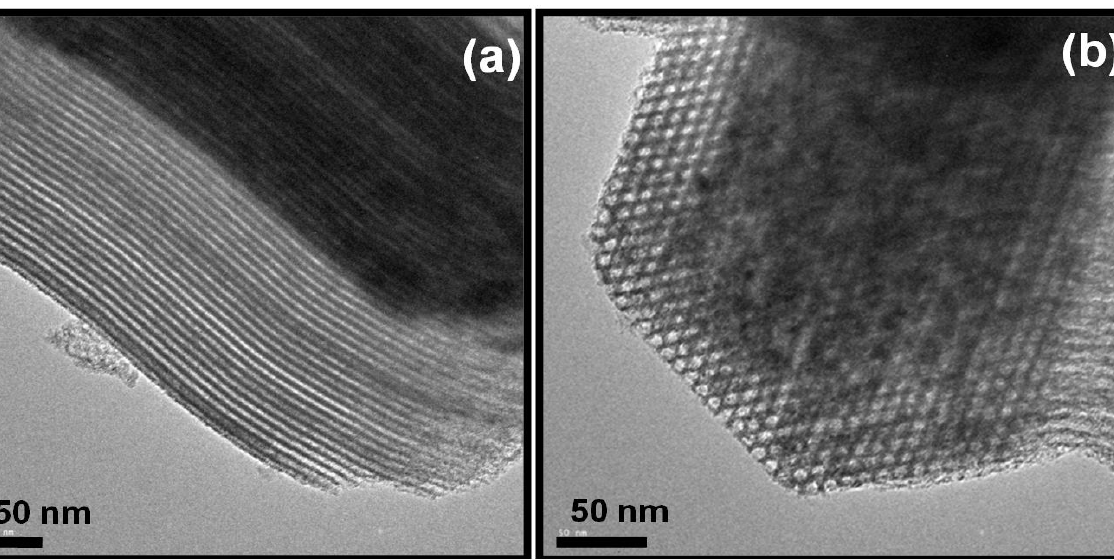
Figure 1. High resolution transmission electron microscopy (HRTEM) micrographs of SBA-15 mesoporous silica. The size and morphology of the highly ordered hexagonal pores in a 2D array ( a ) with long 1D channels ( b ) ( p6mm plane group) can be